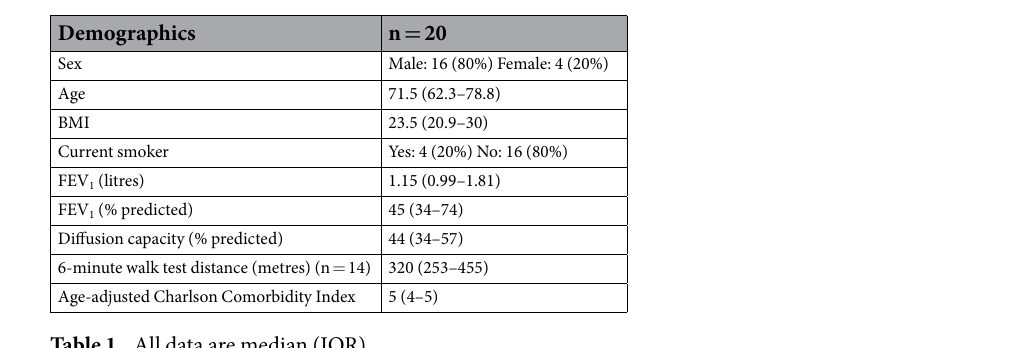
firms the high intra-rater reliability of ultrasound measurements of parasternal intercostal muscles. Intercostal inter-rater reliability was also fair to excellent with ICC between 0.601–0.803 for thickness and 0.685–0.841 for echogenicity.